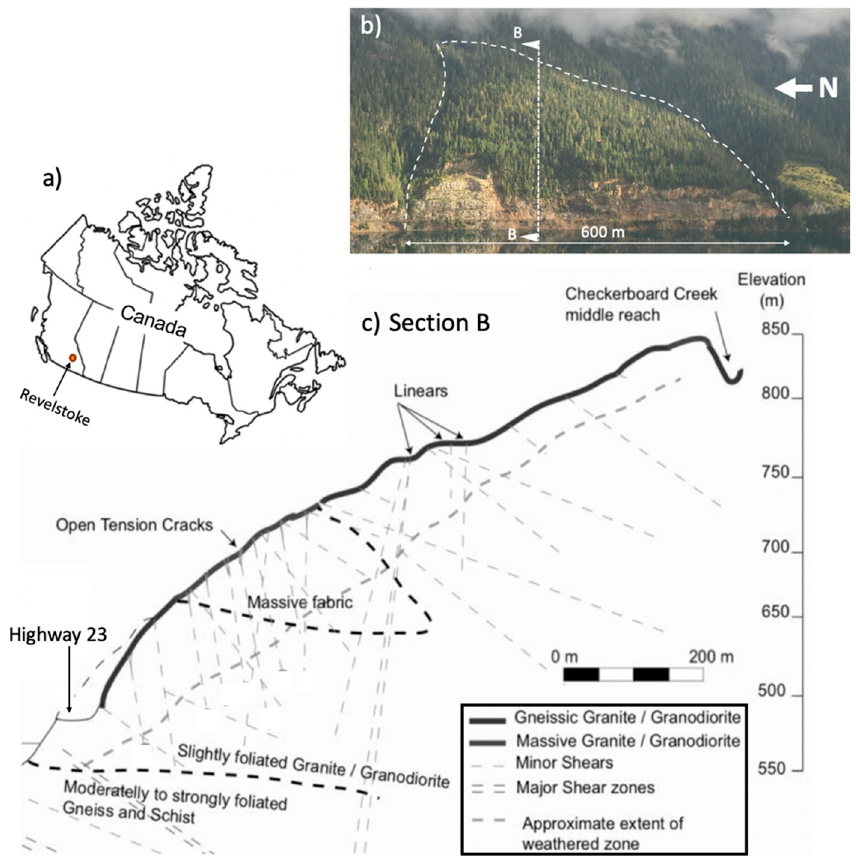
Figure 10. Location of the Checkerboard Creek rock slope ( a ) and front view ( b ). Typical cross section of the slope ( c ). Adapted from [11].